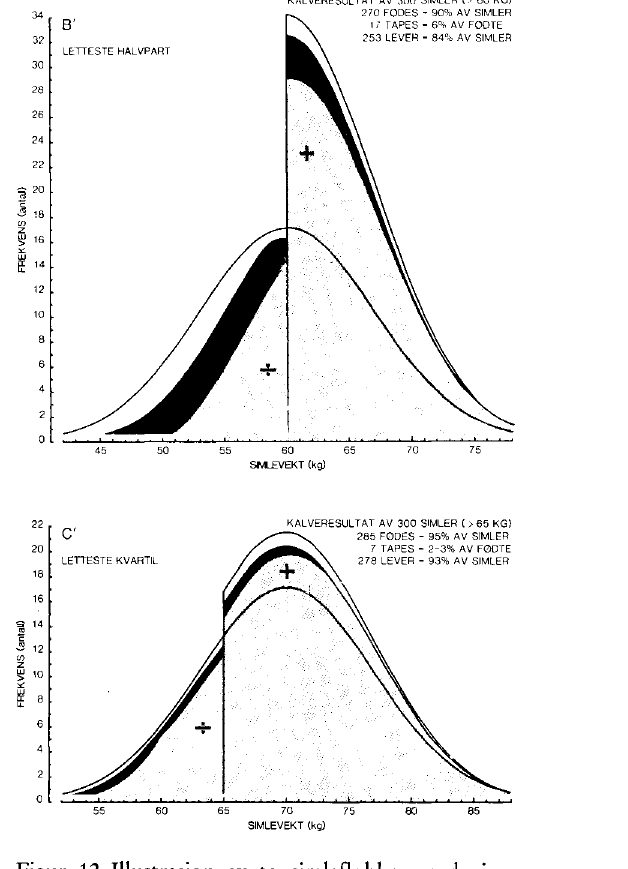
Figur 12. Illustrasjon av to simleflokker med gjenn omsnittsvekt på 60 og 70 kg hvor hen holdsvis letteste halvpart og letteste kvartil er fjernet til fordel for en tilsvarende øk ning innen den tyngste del. Høyre del i begge delfigurene representerer 300 simler som er fordelt i vektklasser på hele kilo. Svart og grå del i «klokkene» angir sam men antall kalver som fødes. Svart del viser kalver som tapes mellom fødsel og høst, mens grå del angir antall kalver som lever om høsten. Beregningene bygger på figur 7. & Fjellheim 1987). Derfor kan man med stor treffsikkerhet «spå» ungsimlevekten ut fra vek ten som kalv. Enkelte ganger slår imidlertid «spådommene» feil. Noen ungsimler blir lettere enn det man hadde forventet. Også eldre simler kan vektmessig falle ut i forhold til det som er «normalt» for alder og tidligere vekt. Disse lette bør uten hensyn til alder hentes ut av flokken og slaktes. Med en gjennomsnittsvekt på 60 kg i